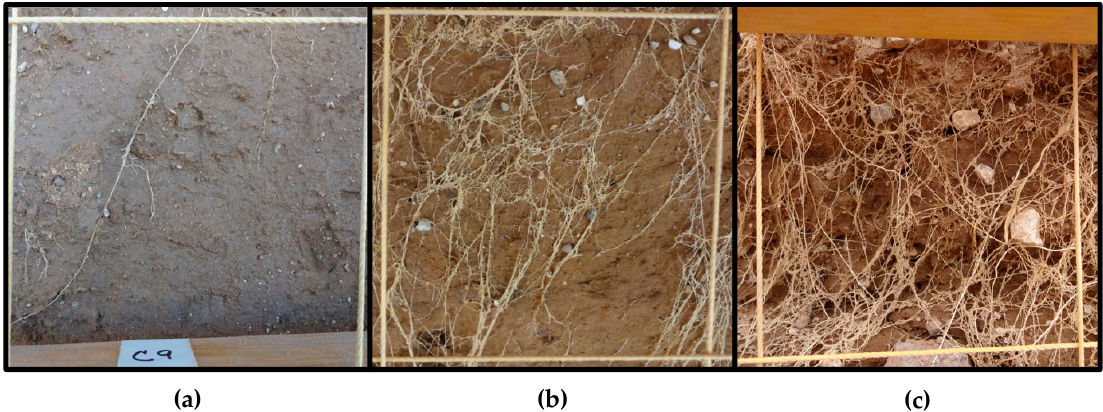
Figure 1. Examples of root density ratings from the profile walls: ( a ) rating of 1; ( b ) rating of 5; ( c ) rating of 10.